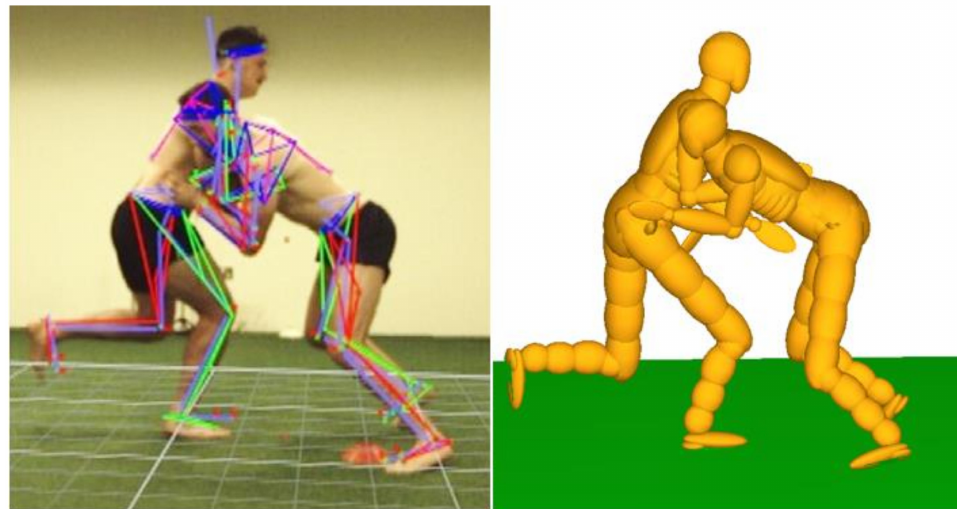
Figure 2. A staged tackle in the Vicon motion analysis laboratory ( left ) reconstructed in a multibody model simulation ( right